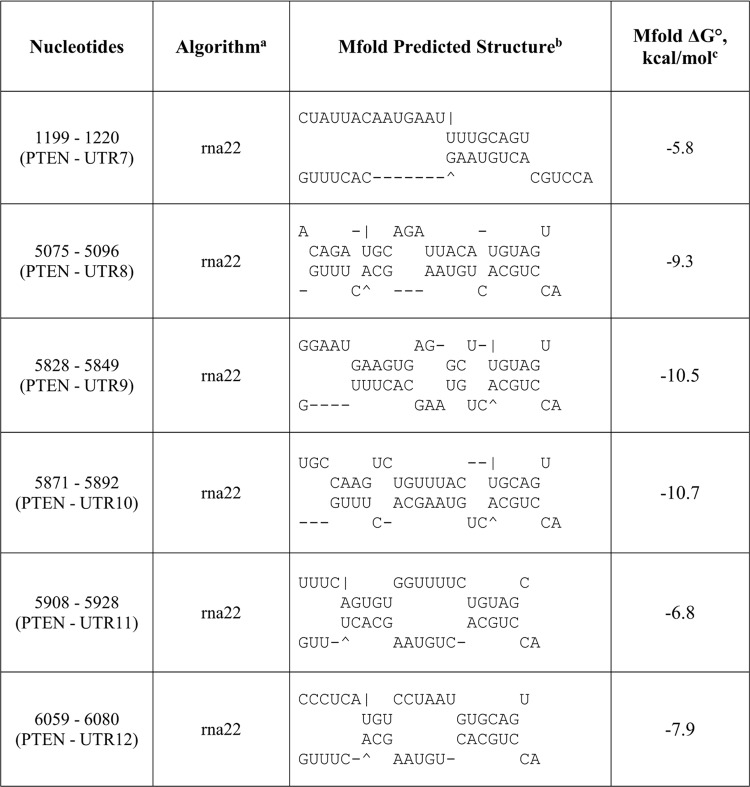
Predicted anti-miR-17-5p binding sites in the 3'UTR of PTEN mRNA as a mimic of miR-17-3p passenger strand.
aThe potential oncomiR:mRNA binding sites were identified by rna22, Targetscan, or miRanda. bTop strand is mRNA (5' ➔ 3') and the bottom strand is oncomiR (3' ➔ 5'). cCalculated at http://mfold.rna.albany.edu/?q=mfold.